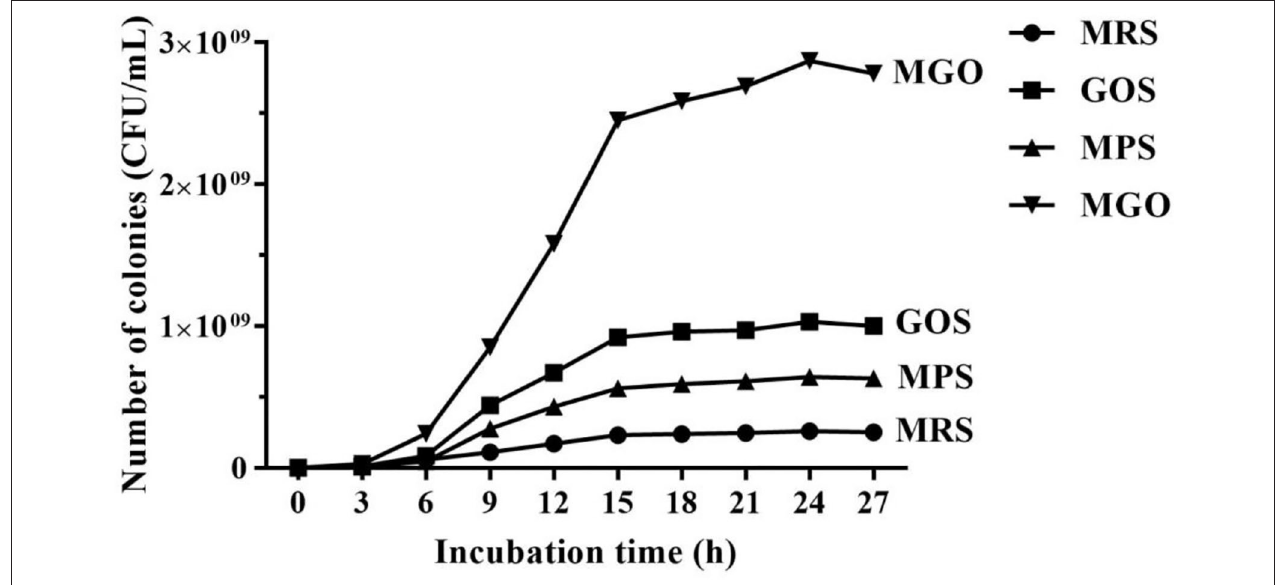
FIGURE 1 | Curve of LGG growth in MRS medium with different prebiotics. MRS, no additional prebiotics added to MRS medium; GOS, 4% ( w/v ) galacto-oligosaccharides added to MRS medium; MPS, 4% ( w/v ) mulberry polysaccharide added to MRS medium; MGO, 4% ( w/v ) mulberry galacto-oligosaccharide added to MRS